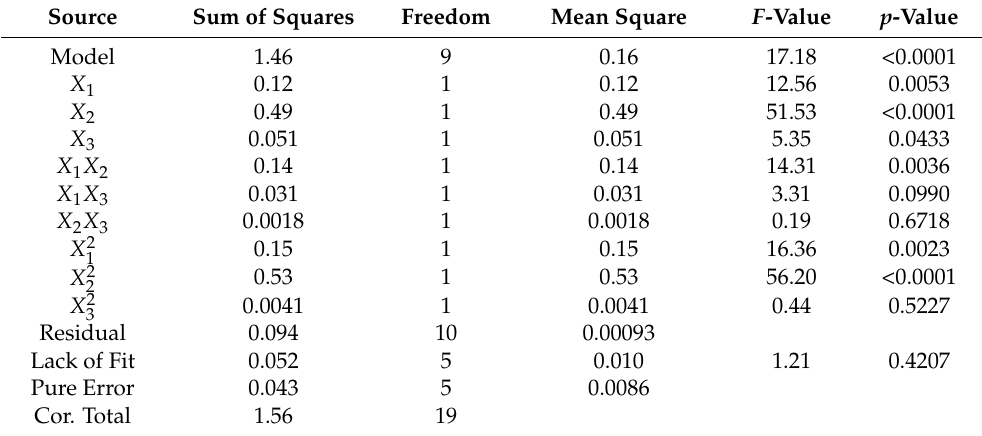
Table 7. Variance analysis results for Y 2